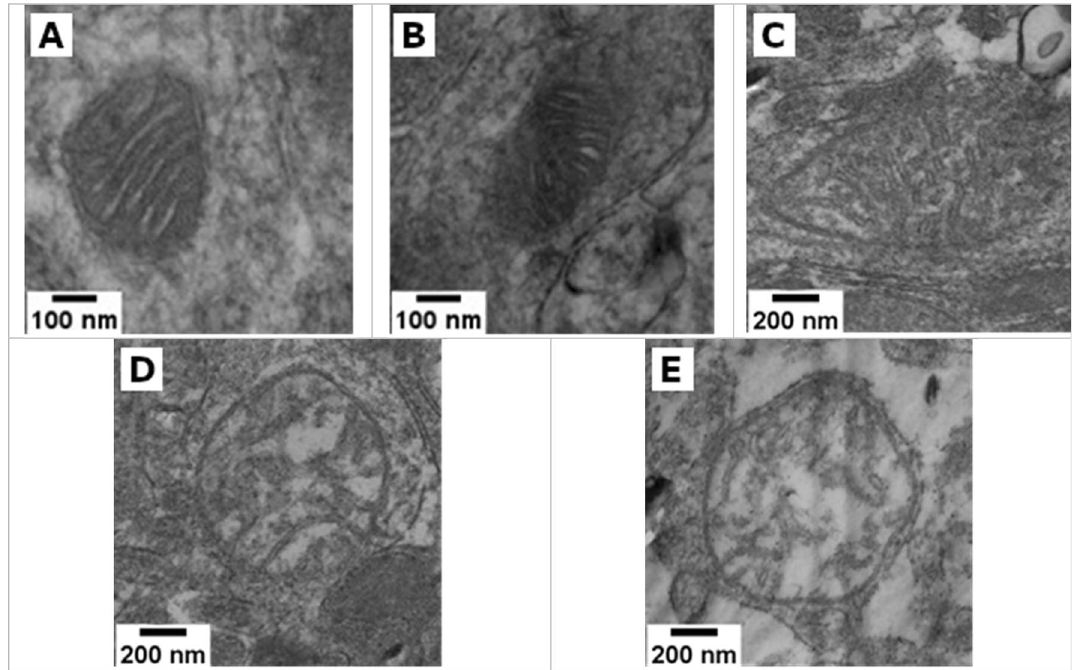
Figure 5. Representative STEM images of normal ( A ), normal vesicular ( B ), vesicular ( C ), swollen vesicular ( D ), and swollen ( E ) mitochondrial morphotypes found in the tissues of both studied